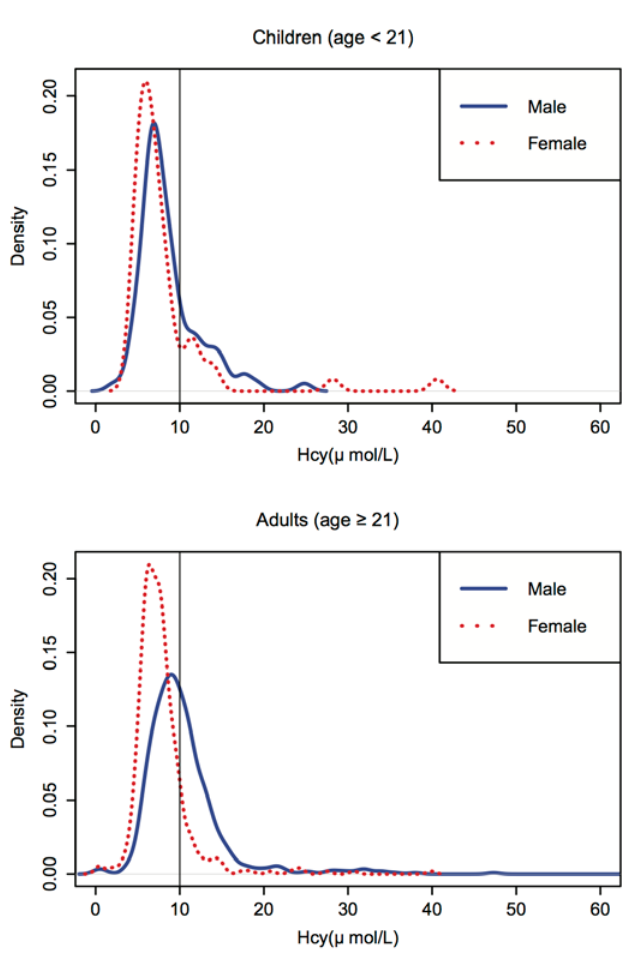
Figure 2. Homocysteine distribution by gender for children (age < 21) and adults (age ≥ 21) † . Note: The distribution of the values was positively skewed and ranged from 0.3 to 74.7 μmol/L for the adult group and from 2.2 to 40.6 μmol/L for the child group. For both age groups, the distribution of Hcy was shifted toward higher values for males compared to females. † The distribution figure of adult homocysteine levels was trimmed at 60 for